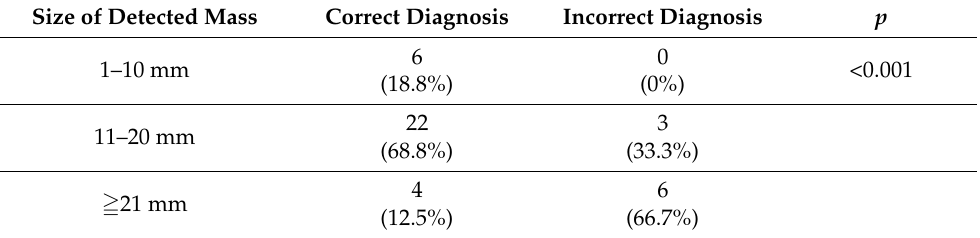
Table 3. The association between pancreatic mass size and the accuracy of SPACE results of Fisher’s exact test for trends showing the negative correlation between pancreatic mass size and the accuracy of SPACE.